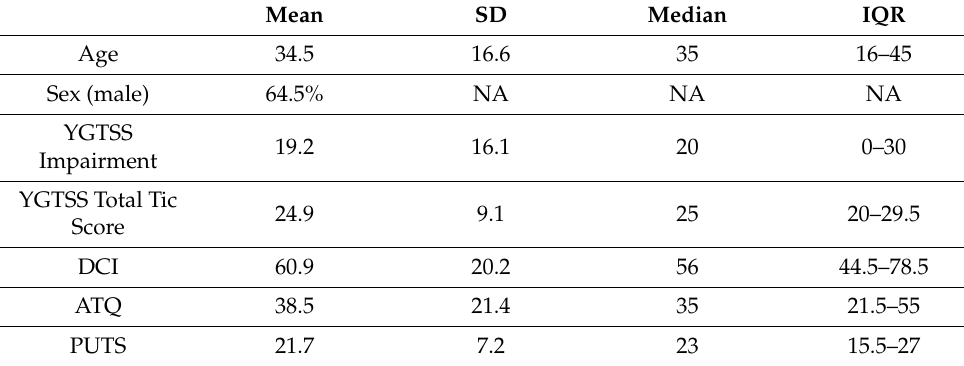
Table 1. Baseline characteristics of all participants (n =